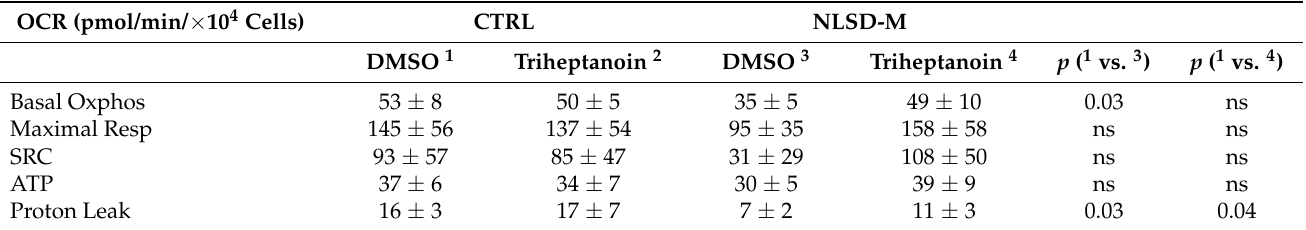
Table 3. Mitochondrial respiration of CTRL vs. NLSD-M fibroblasts.